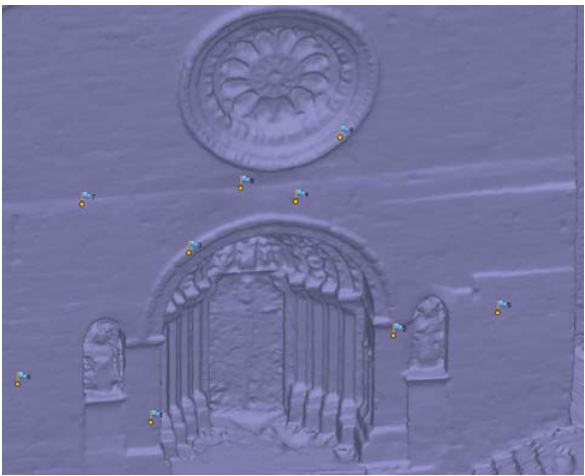
Figure 14. Perspective of the Dense Surface Model (DSM).